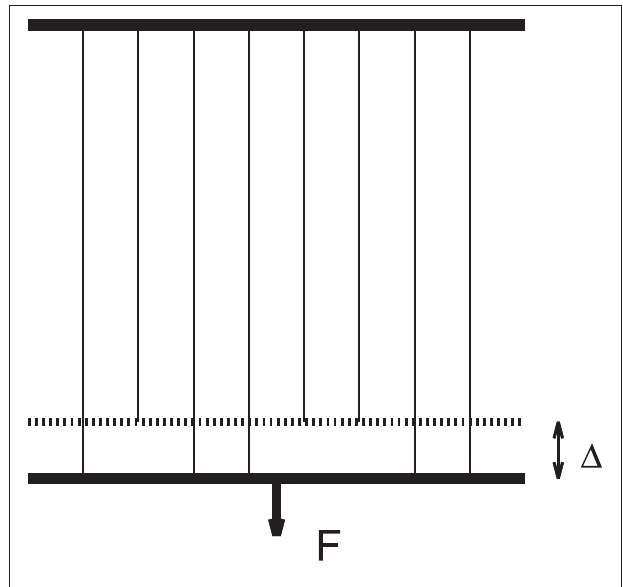
FIGURE 1 | The fiber bundle